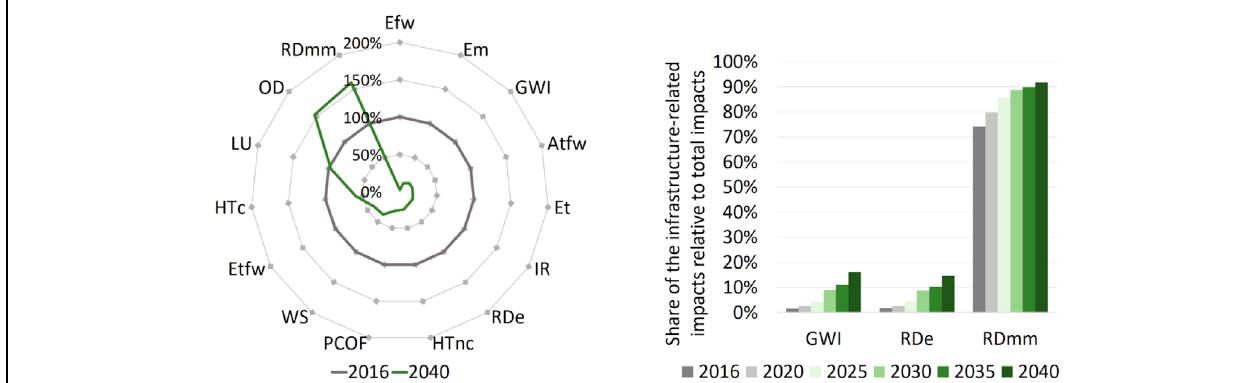
FIGURE 6 | Environmental impacts of the production processes in case study 3 for year 2040, relative to the base year 2016 (left). Share of infrastructure-related impacts on the total impacts for selected impact categories (right). Shown impact categories: freshwater eutrophication (Efw), marine eutrophication (Em), global warming impact (GWI), freshwater and terrestrial acidification (Atfw), terrestrial eutrophication (Et), ionizing radiation (IR), resource depletion, energy (RDe), human toxicity, non-carcinogenic (HTnc), photochemical ozone formation (PCOF), water scarcity (WS), freshwater ecotoxicity (Etfw), human toxicity, carcinogenic (HTc), land use (LU), ozone depletion (OD), resource depletion, mineral and metal (RDmm).